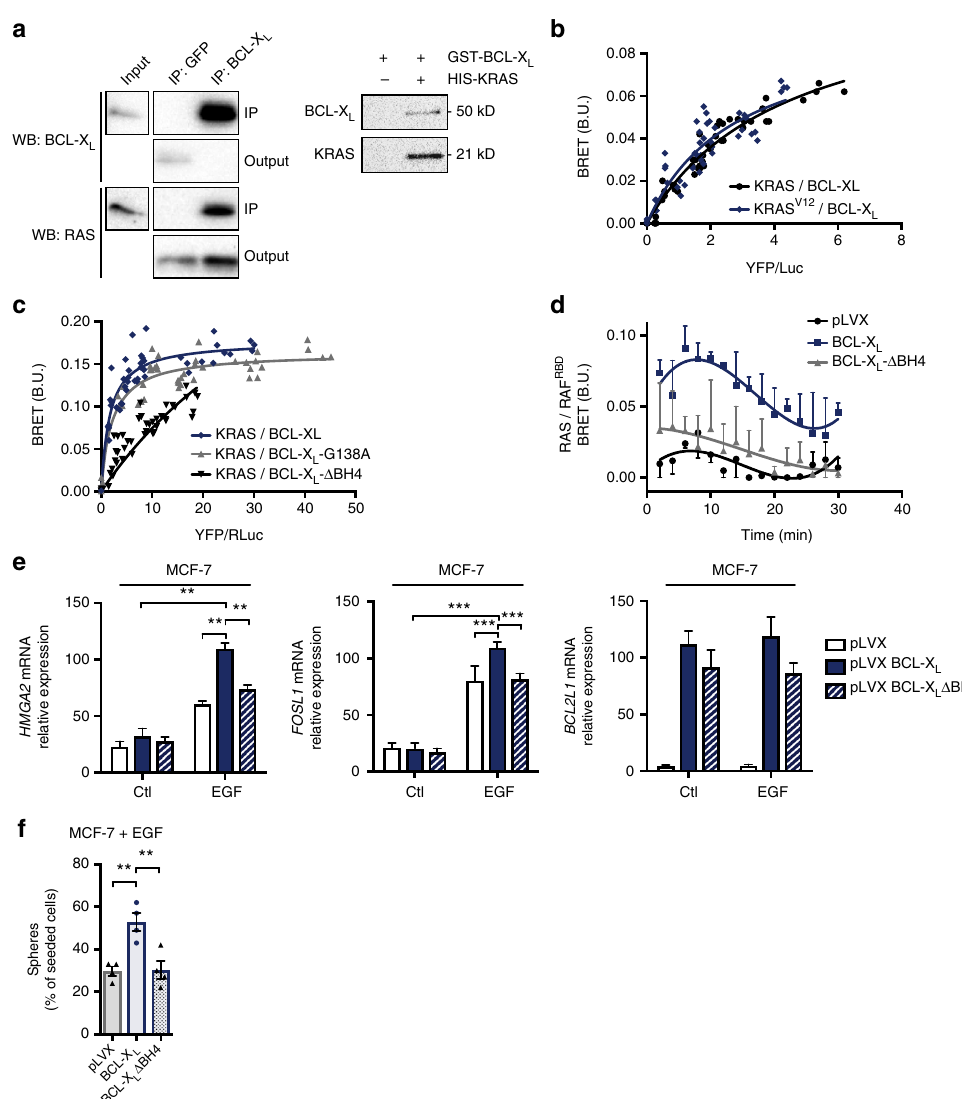
Fig. 5 BCL-X L interacts with KRAS through its BH4 domain to favour its signalling. a Left: MCF10A KRASV12 lysate was used to perform immunoprecipitation with a control or an anti-BCL-X L antibody. Western blot immunodetection was done using anti pan-RAS or anti BCL-X L antibody. Right: Pulldown assays between His-tagged KRAS and GST-tagged BCL-X L were analysed by western blot immunodetection as in immunoprecipitation assay (see Methods for more details). b , c Interaction between KRAS and BCL-X L in MCF-7 cells was assessed by BRET saturation curve assays using increasing amount of plasmid encoding YFP-BCL-XL, YFP-BCL-XL- Δ BH4, or YFP-BCL-XL-G138A and a fi xed amount of plasmid encoding Rluc-KRAS. BRET ratios were obtained for every YFP- BCL-X L plasmid concentration and plotted as a function of the ratio of total acceptor fl uorescence to donor luminescence. Data were fi tted using a nonlinear regression equation assuming a single binding site. Data presented are representative of three independent experiments. d RAS activity following EGF stimulation. BRET-based KRAS activity sensor (see Methods for details) was used to monitor the activity of KRAS after adding 200 nM EGF to cell medium at t = 0. Measurements were done in control cells (pLVX), BCL-X L overexpressing cells (BCL-X L ) and BCL-X L - Δ BH4 overexpressing cells ( Δ BH4). Data presented are representative of three independent experiments. e qPCR analysis of HMGA2 , FOSL1 and BCL2L1 mRNA in MCF7 control cells (pLVX), BCL-X L overexpressing cells (BCL-X L ) and BCL-X L Δ BH4 overexpressing cells ( Δ BH4) after overnight starvation and treatment with 20 ng ml − 1 EGF for 24 h. Mean and SEM of 3 independent experiments are represented as relative quantity of mRNA normalised to the mean of RPLP0 , RPS18 and ACTB relative expression (two-tailed unpaired t-test). f Percentage of sphere forming cells in bulk population of EGF-treated MCF-7 cells stably transfected with either a control plasmid (pLVX), a plasmid encoding BCL-X L , or a plasmid encoding BCL-X L - Δ BH4. Mean and SEM of 4 independent experiments are represented (two-tailed unpaired